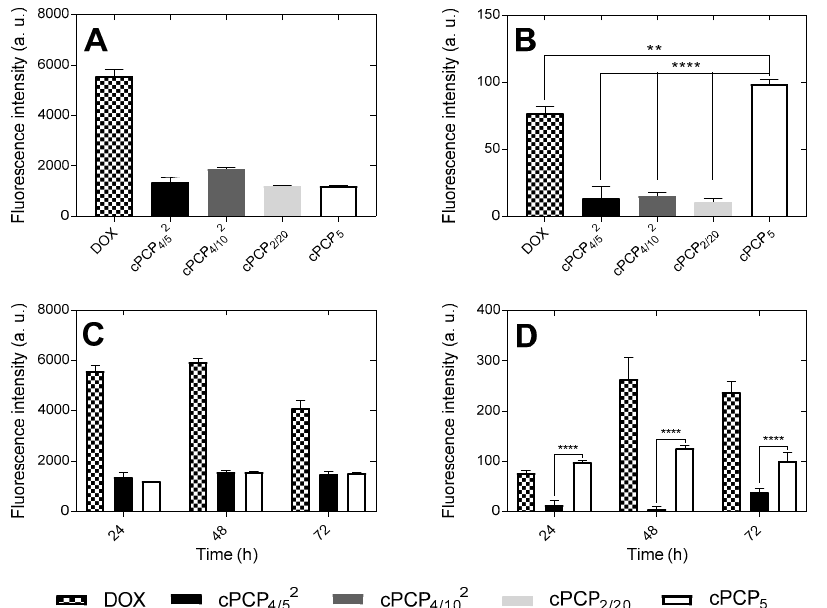
Figure 6. HT1080-DOX fluorescence accumulation in ( A , B ) nuclei after 24 h of incubation with free DOX or equimolar concentrations (DOX eq) of cPCP 4/52 , cPCP 4 /1 02 , cPCP 2/10 and cPCP 5 . Comparison of DOX fluorescence accumulation in ( C , D ) nuclei after 24, 48 and 72 h incubation with free DOX, cPCP 4/52 and cPCP 5 (** p < 0.001, **** p < 0.0001).